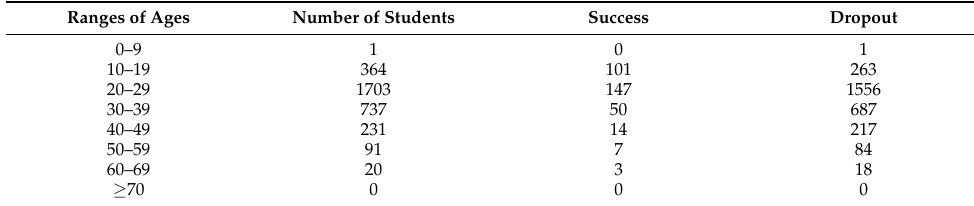
Table A1. Distribution of Students Across Different Age Groups.